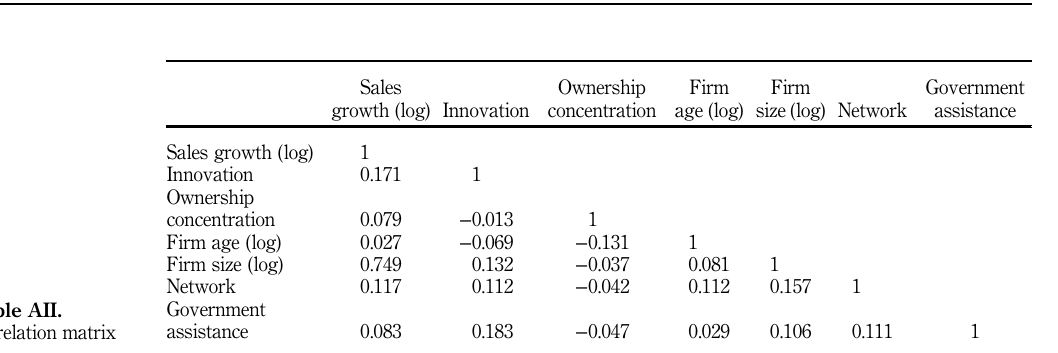
Table AI. Variable definitions and summary statistics